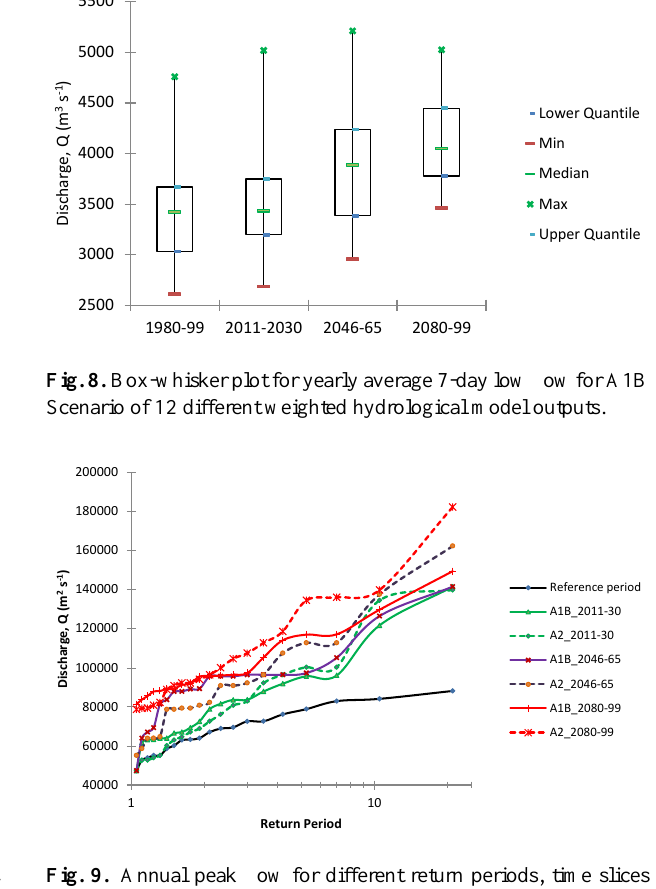
Fig. 9. Annual peak flow for different return periods, time slices and scenario’s obtained from a weighted average of extreme value analysis of the 12 model